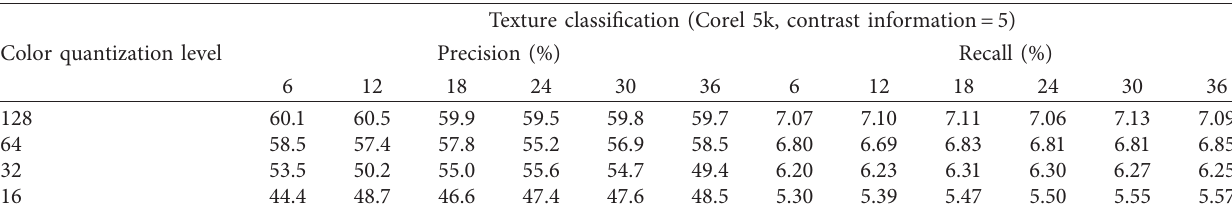
Table 4: Average retrieval precision and average retrieval recall of NRLGO at varying values of gradient orientation and color quantization levels by keeping local contrast information fixed at 5 on Corel 5k in RGB.